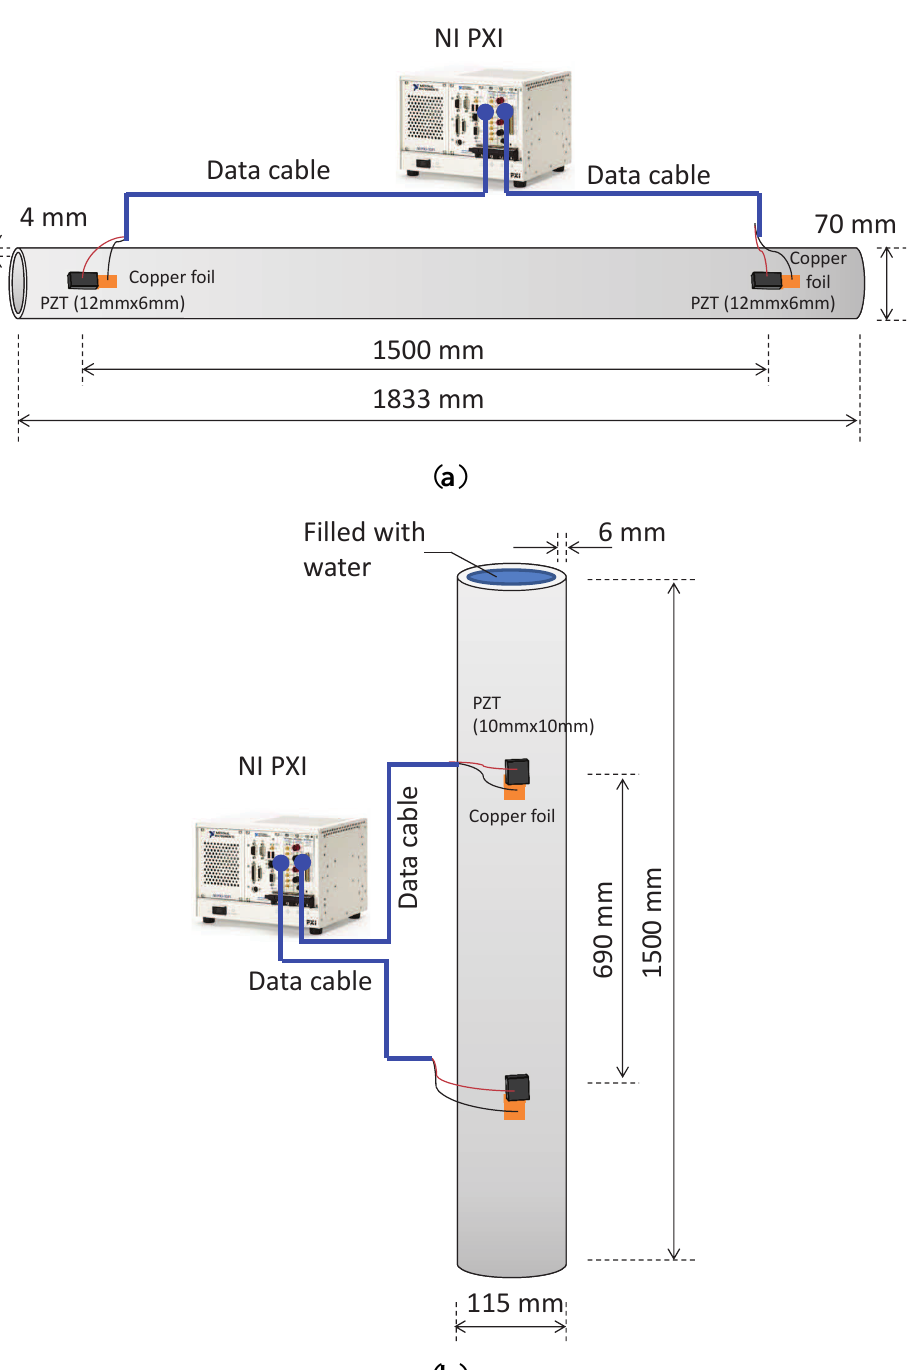
Figure 2. Illustration of experimental setup with cable connections and circuit wiring. ( a ) A carbon steel pipe specimen; ( b ) a stainless steel pipe specimen. Water can be filled into the